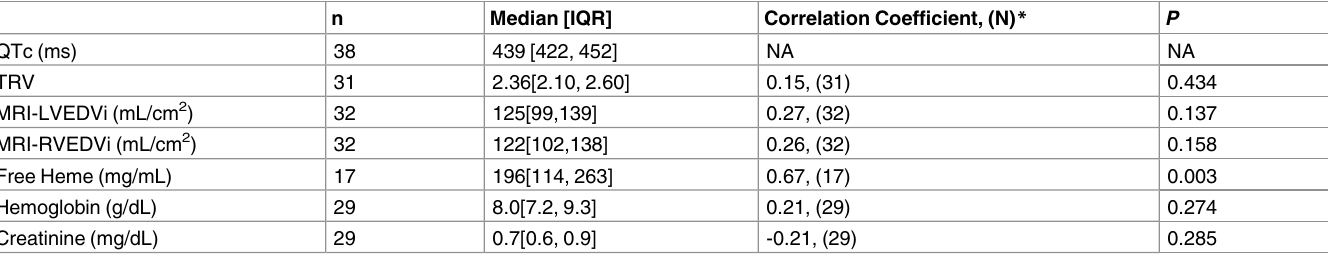
Table 2. QTc, echocardiography, CMR, and laboratory characteristics of the UC Cohort.